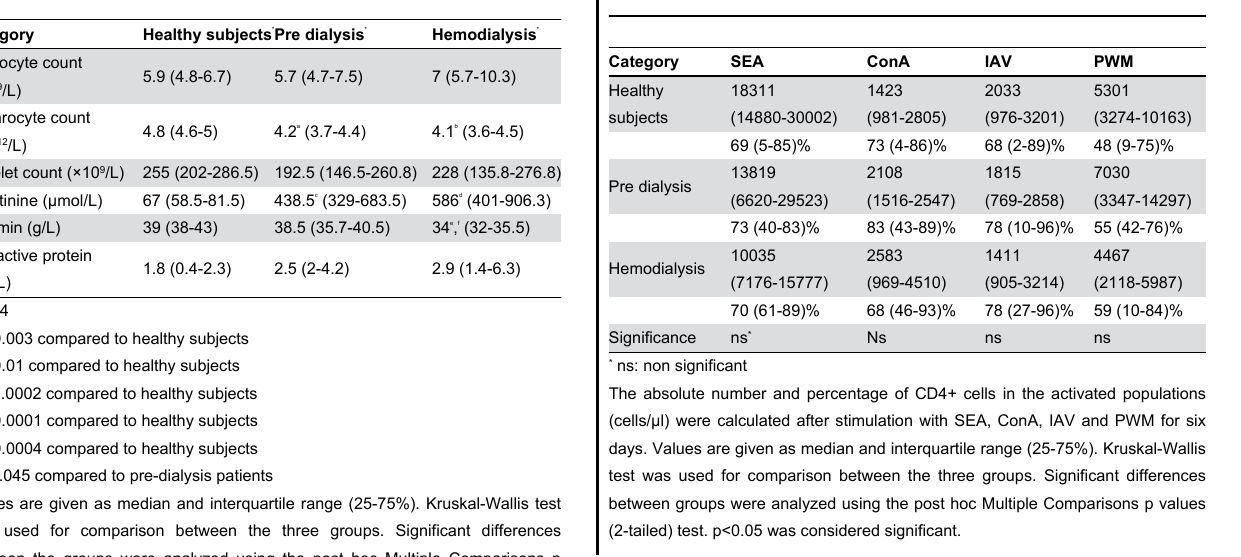
Table 4. Absolute number and percentage of CD4+ cells in the activated lymphoblasts (cells/µl).